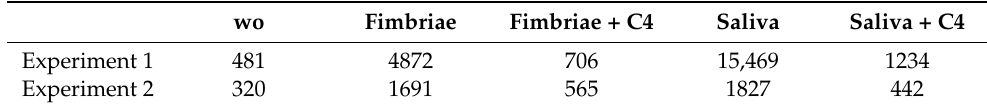
Figure 3. Butyrate suppressed P. gingivalis fimbriae and saliva-induced IL6 and CXCL2 expression in primary macrophages. Primary macrophages were exposed overnight to 10 mM of acetate (C2), propionate (C3), and butyrate (C4) in the presence of 100 µg/mL fimbriae and 5% saliva. Each format shape represents data from individual experiments with the median. Statistical analysis was based on the Friedman test and corrected p values are indicated. Table 2. Butyrate suppressed P. gingivalis fimbriae and saliva-induced IL6 levels in primary macrophages. Primary macrophages were exposed overnight to 10 mM of butyrate (C4) in the presence of 100 µg/mL fimbriae from P. gingivalis and 5% saliva. Data represent the concentration of IL6 in pg/mL in the supernatant from two independent experiments.